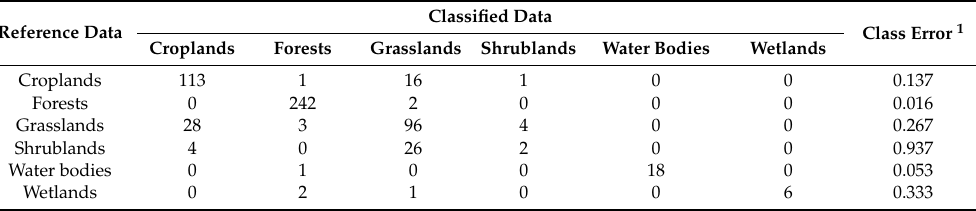
Table 6. Confusion matrix of land cover classification for 2010.